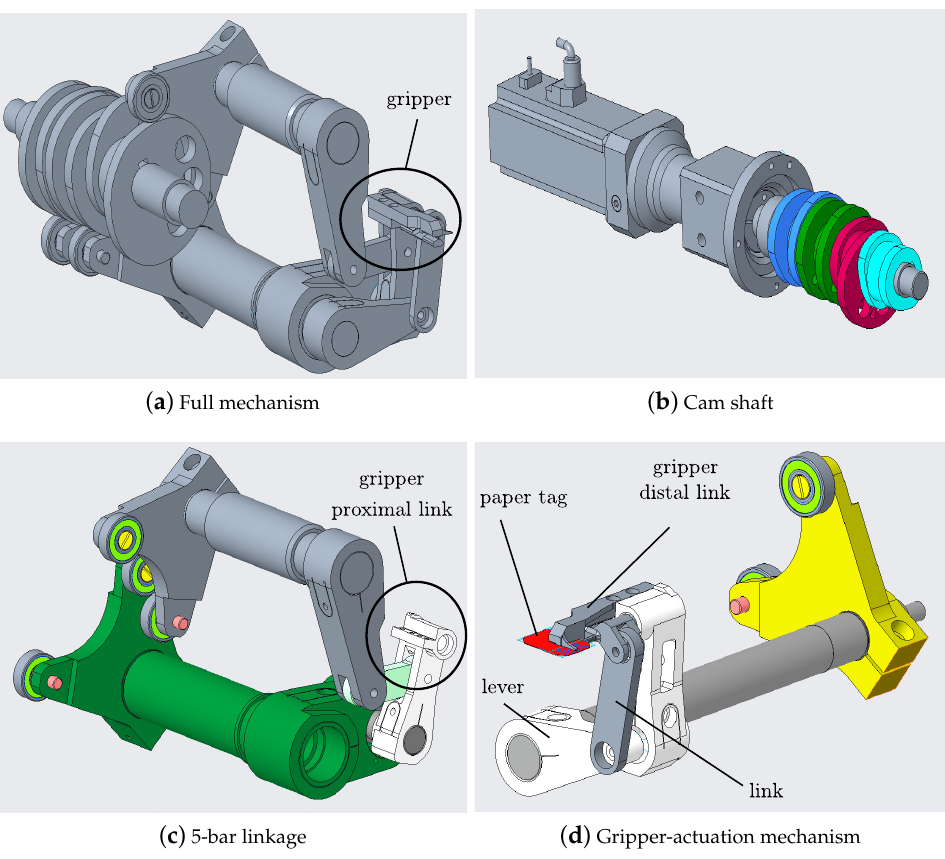
Figure 1. An overview of the complete mechanism ( a ), the cam shaft ( b ), the 5-bar linkage used for the gripper movement ( c ), and the gripper actuation mechanism ( d